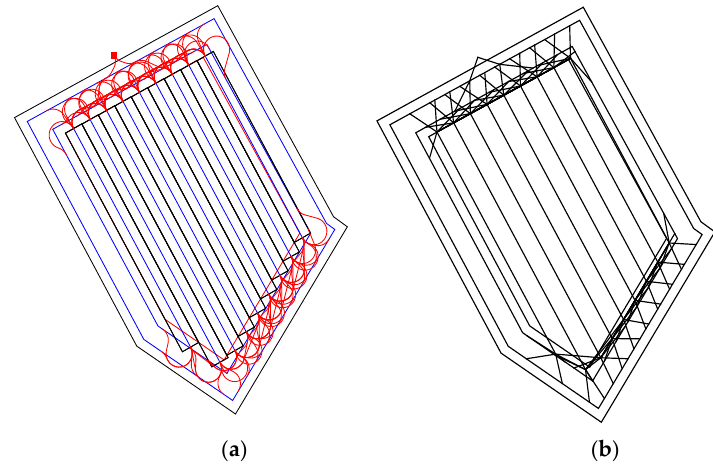
Figure 7. The fixed entities and all connectors ( a ), and their conversion to an undirected graph ( b ).